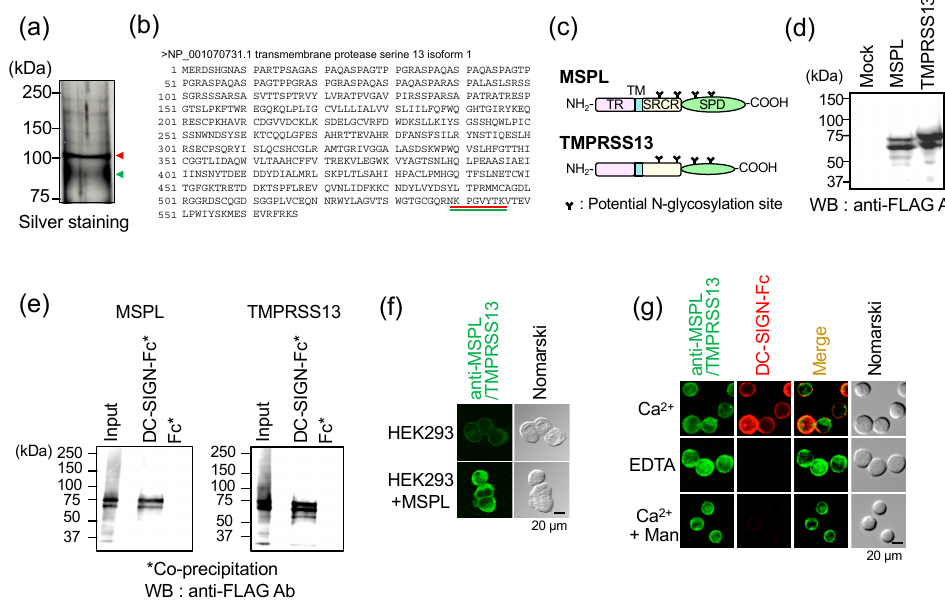
Figure 1. Identification of mosaic serine protease large-form (MSPL) / transmembrane protease serine 13 (TMPRSS13) as novel ligands of dendritic cell-specific intercellular adhesion molecule-3-grabbing nonintegrin (DC-SIGN) in colon cancer COLO205 cells. ( a ) DC-SIGN ligands were purified through affinity chromatography. The 90-kDa and 100-kDa protein bands were both excised and analyzed by liquid chromatography–mass spectrometry (LC-MS/MS). The arrowheads indicate proteins eluted from the affinity column. ( b ) Identification of TMPRSS13 through LC-MS. The detected peptide sequences are underlined with red (upper band) and green (lower band) lines. ( c ) Domain structures and potential N-glycosylation sites of MSPL and TMPRSS13. TR, tandem repeat domain; TM, transmembrane domain; SRCR, scavenger receptor cysteine-rich domain; SPD, serine protease domain. ( d , e ) Glycan-dependent interaction of DC-SIGN with recombinant MSPL and TMPRSS13 expressed in HEK293 cells. ( d ) HEK293 cells were transfected with full-length MSPL or TMPRSS13. The cell lysates were subjected to western blotting (WB) using anti-FLAG M2 antibody. ( e ) Lysates of MSPL and TMPRSS13 transfectant cells were incubated with DC-SIGN-Fc beads. Pulled-down proteins were subjected to Western blotting (WB) using anti-FLAG M2 antibody. ( f ) Staining of HEK293 MSPL transfectant cells with anti-TMPRSS13 antibody. ( g ) Double staining of COLO205 cells with DC-SIGN-Fc and anti-TMPRSS13